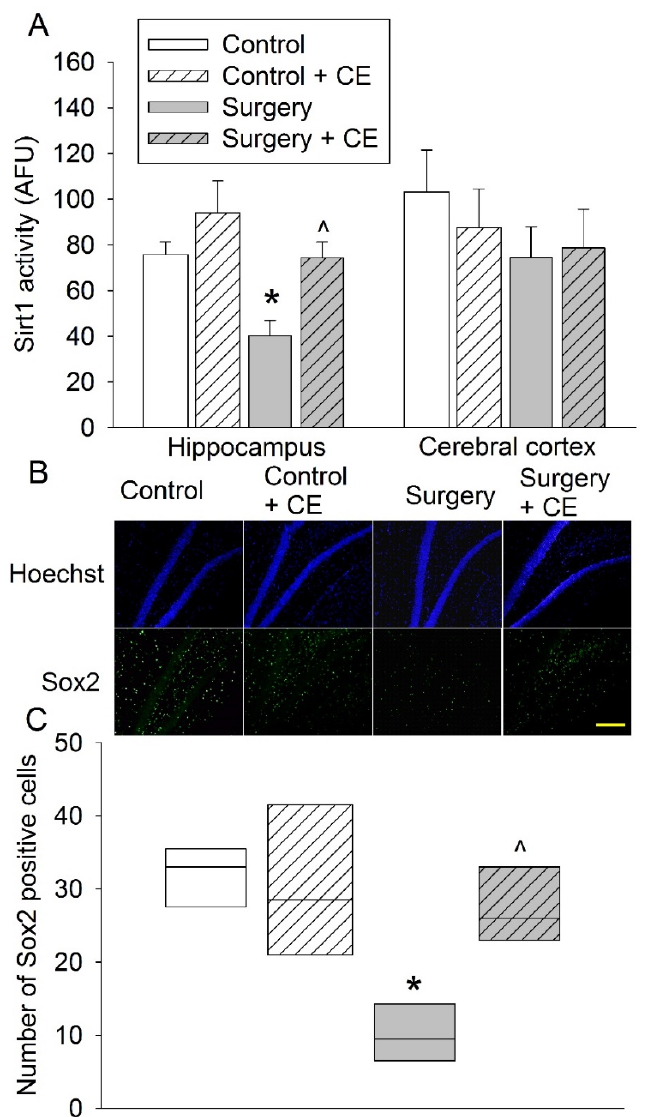
Figure 7. Effects of cognitive enrichment and surgery on Sirt1 activity and Sox2 expression in the brain. Eighteen-month-old mice were subjected to right carotid artery exposure and cognitive enrichment. Their brains were harvested 3 days after surgery for Sirt1 activity measurement or 2 weeks after surgery for Sox2 staining. ( A ) Sirt1 activity. ( B ) Representative images of hippocampal dentate gyrus. Scale bar: 200 µ m. ( C ) Quantitative results. Results are means ± S.E.M. ( n = 6–8). * p < 0.05 compared with control, ˆ p < 0.05 compared with surgery group.